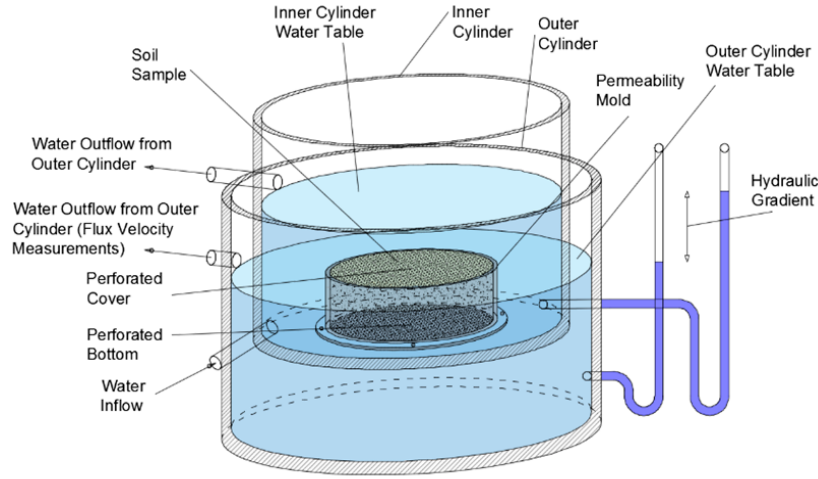
Figure 4. The permeameter scheme.